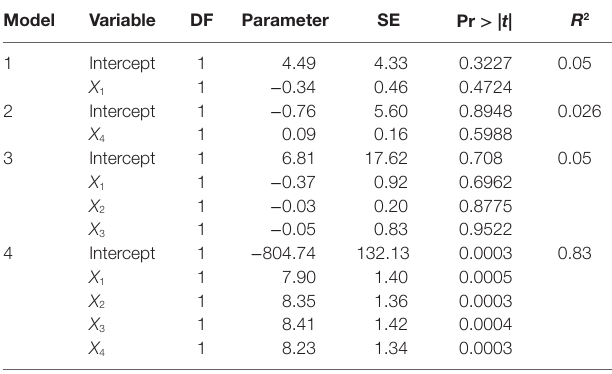
TABLe 4 | effects of collinearity.